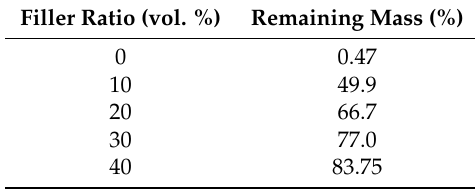
Table 3. The residual masses for each of the composites after thermogravimetry. Filler Ratio (vol. %) Remaining Mass